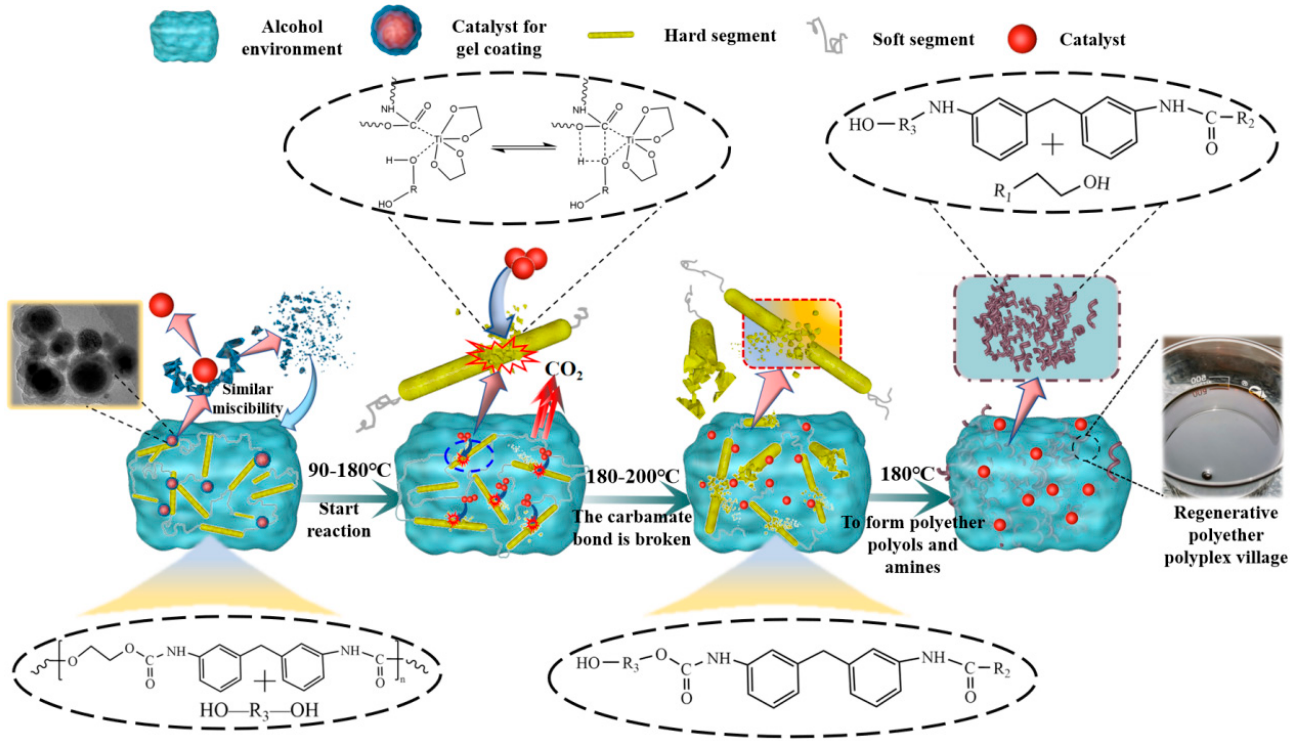
Figure 4. Mechanism of the titanium glycol-catalyzed degradation of 2,2 ′ -diphenylmethane diiso- cyanate (MDI)-type polyurethane hard foam.